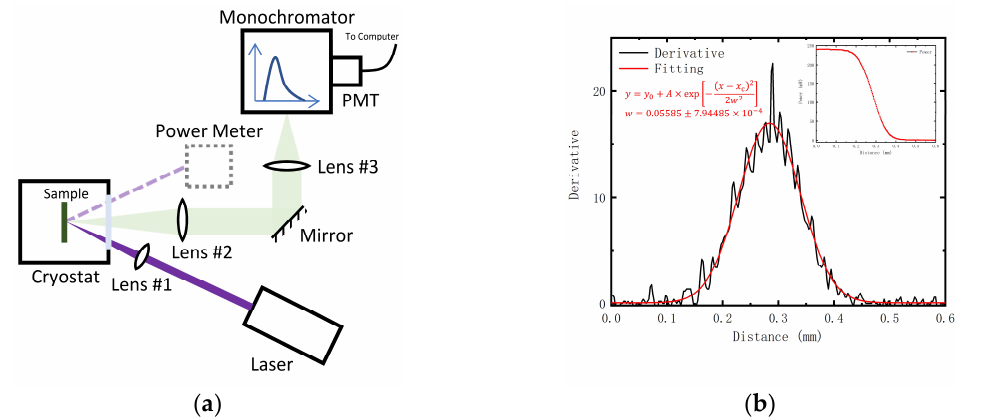
Figure 1. ( a ) A schematic of the experimental apparatus in which the power meter shown with dashed line is used to improve the accuracy of the experiment mentioned in the section of discussion; ( b ) The gaussian fit result of derivative of measured data at excitation power of 250 mW as described in the inset to determine the spot radius on the sample using the knife-edge method.